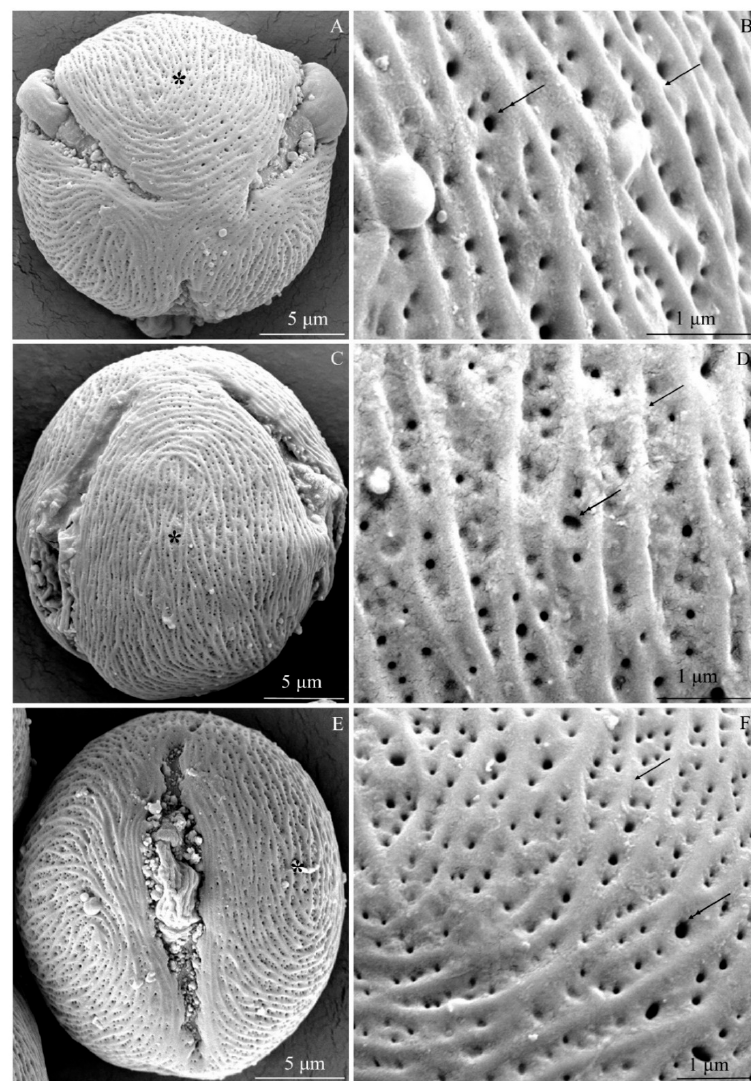
Figure 1. A – F . Tricolpate-porate pollen grains ( A , C , E ) and fragments of exine surface sculpture ( B